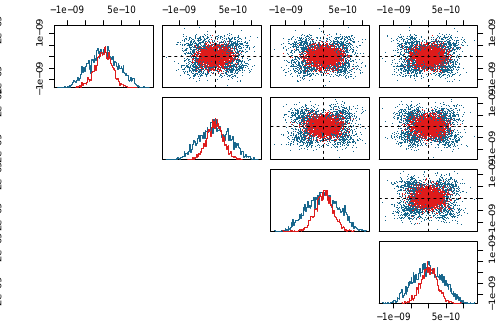
(b) Approximations over 9 rounds of Fly . For each pair of approximations we observe four distinct clusters in the distributions.